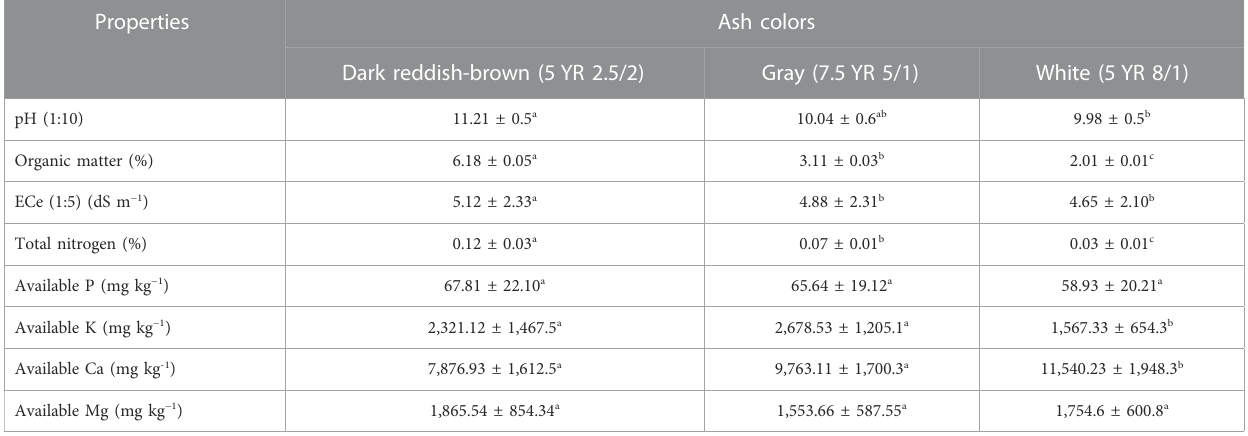
TABLE 2 Chemical properties of ash (mean ± SD). Properties